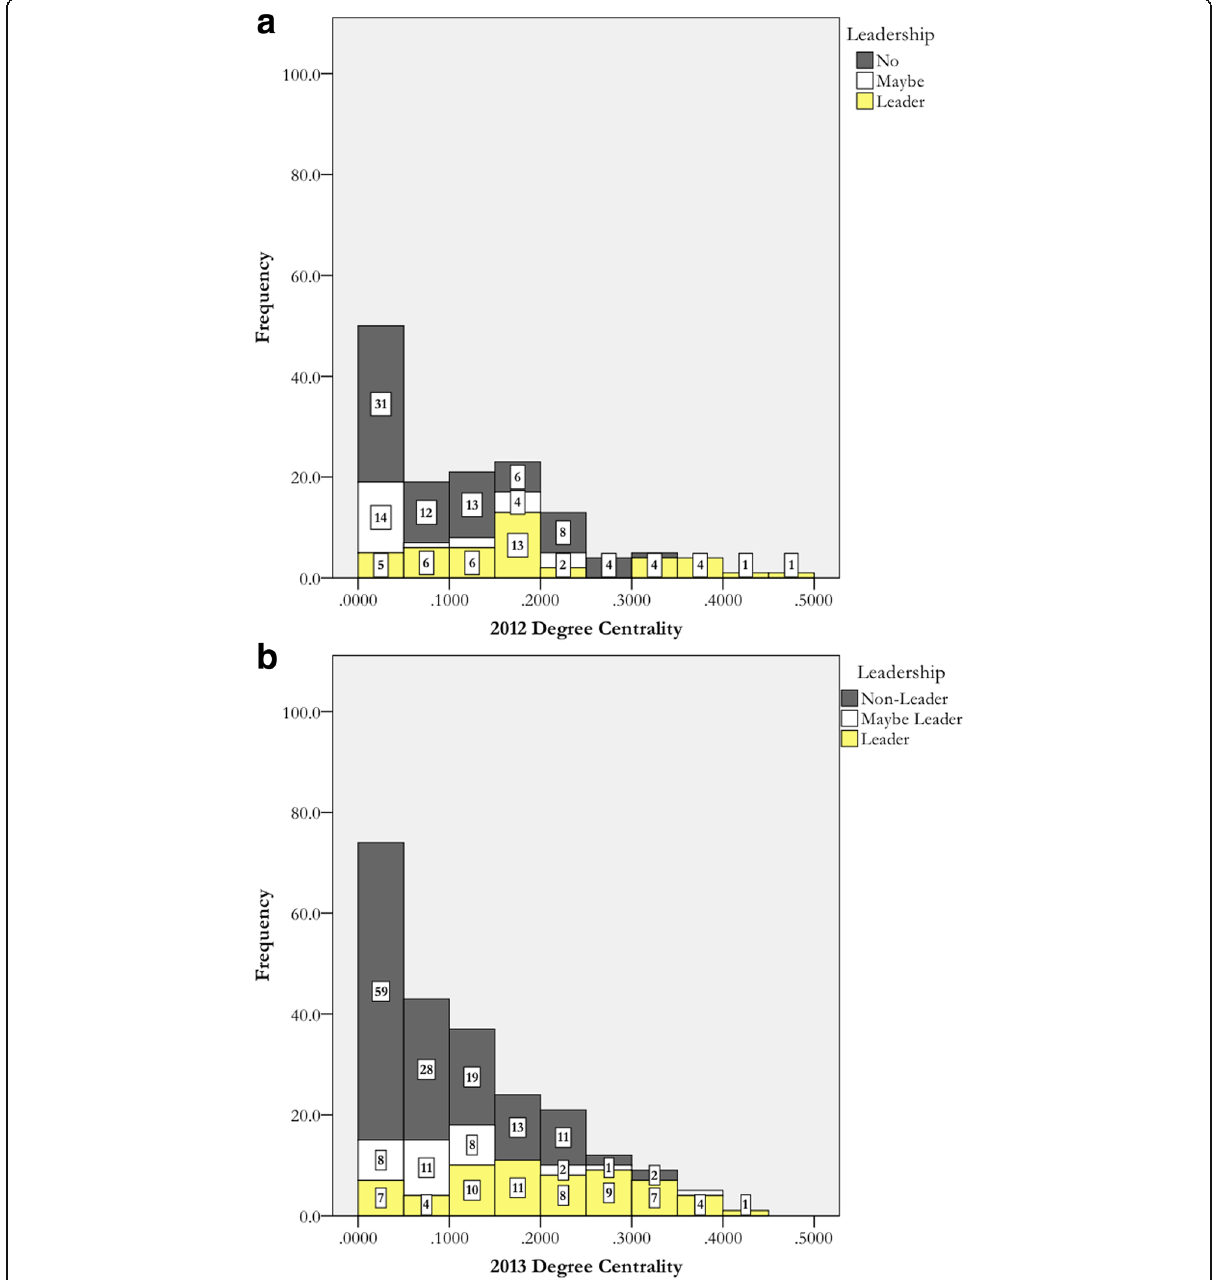
Fig. 2 Histograms depicting the distribution of degree centralities and colored by leadership identity for 2012 ( a ) and 2013 ( b